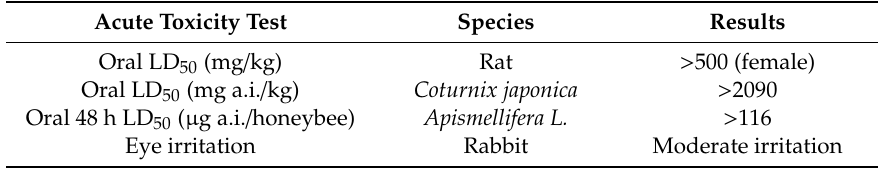
Table 6. Toxicity results of the compound 4j